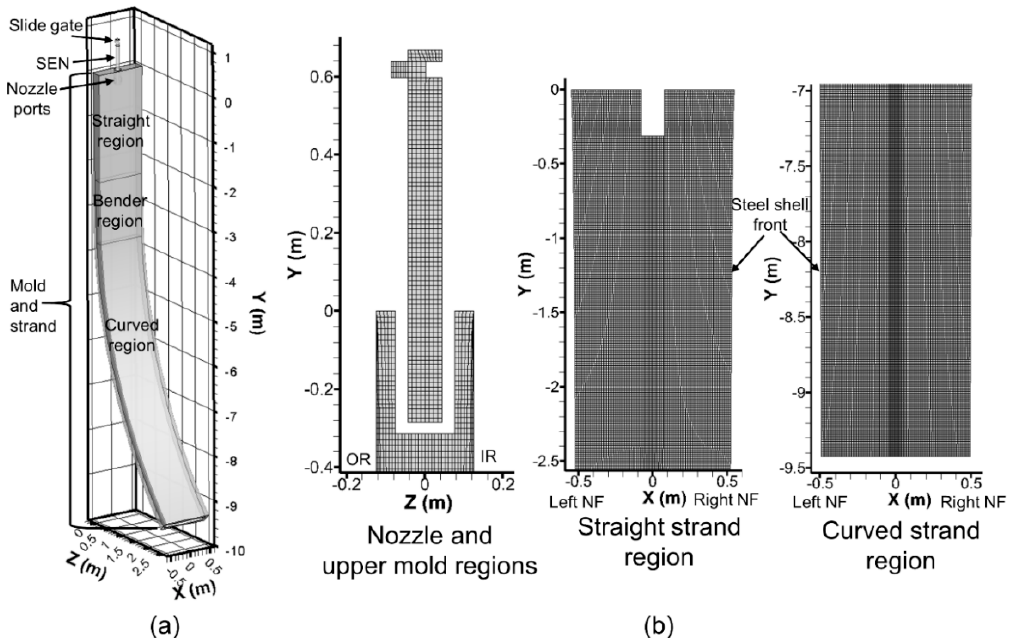
Figure 2. Three-dimensional ( a ) domain and ( b ) mesh of the computational models of the continuous caster nozzle and strand.